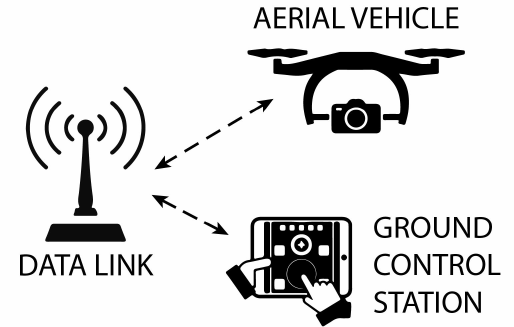
Figure 2. General architecture of an unmanned aerial